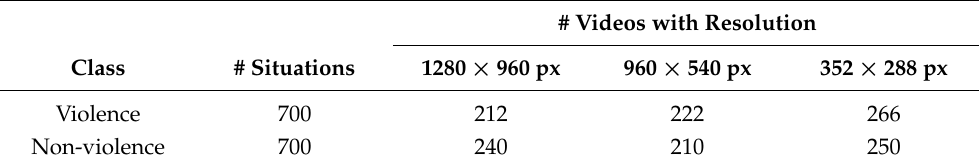
Table 2. The basic information concerning the Bus Violence benchmark, including the number of situations for violent and non-violent actions and the basic number of frames.